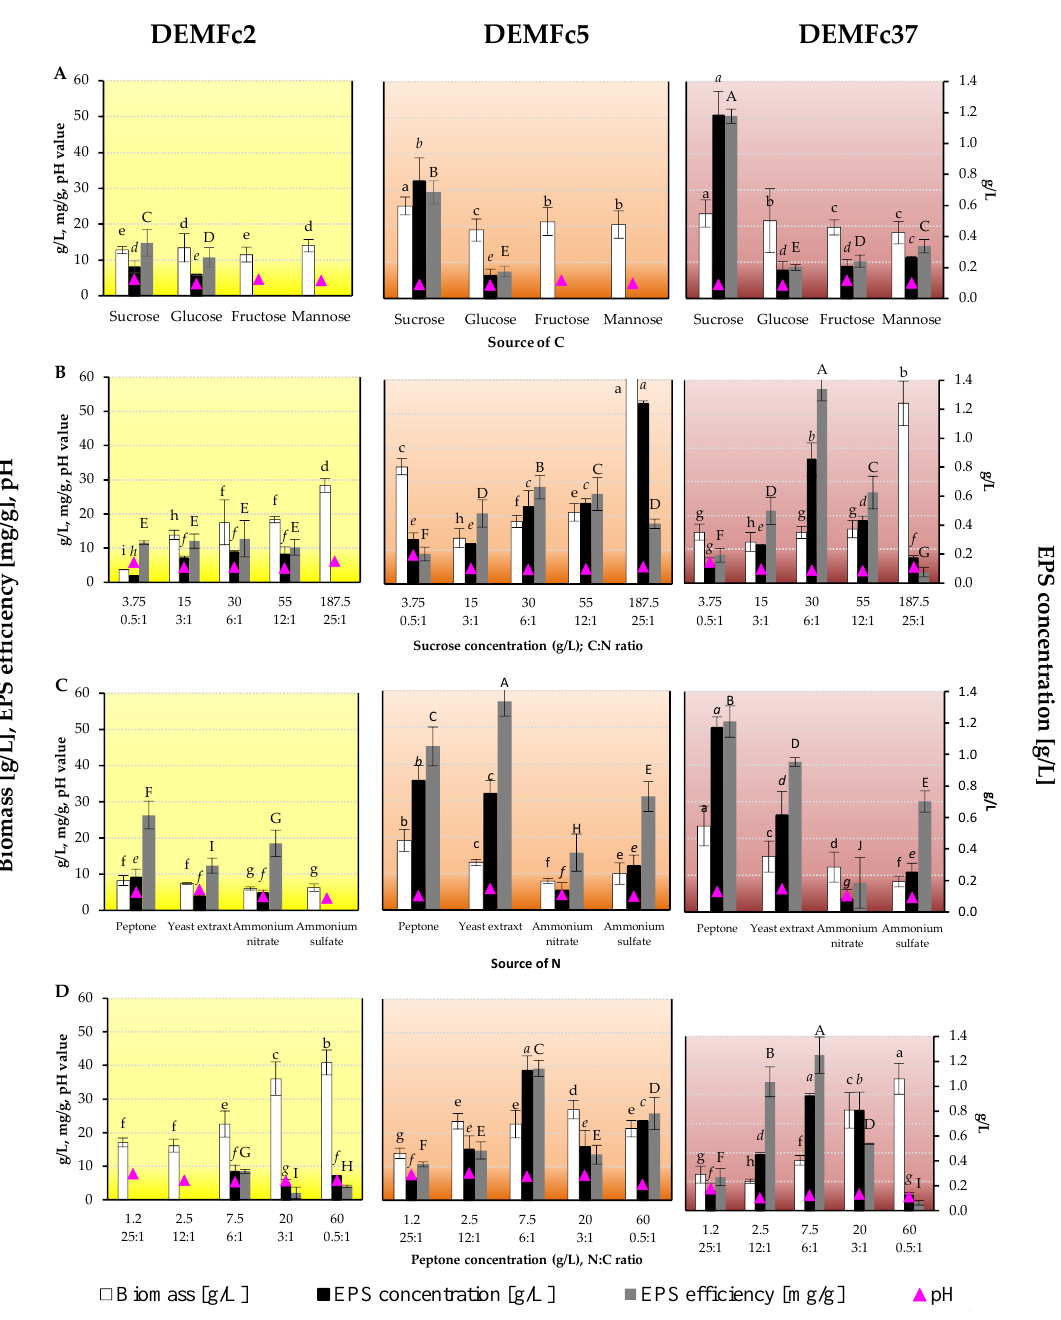
Figure 6. The EPS concentration in F. culmorum strain culture on: ( A ). carbon source, ( B ). sucrose concentration (g/L), C:N ratio, ( C ). nitrogen source, ( D ). peptone concentration (g/L), N:C ratio. One-way ANOVA with post hoc Tukey’s HSD test, p < 0.05. Mean values labeled with the same letter within the same series are not significantly different ( p > 0.05). Standard deviations are shown as deviation bars ( n = 9).